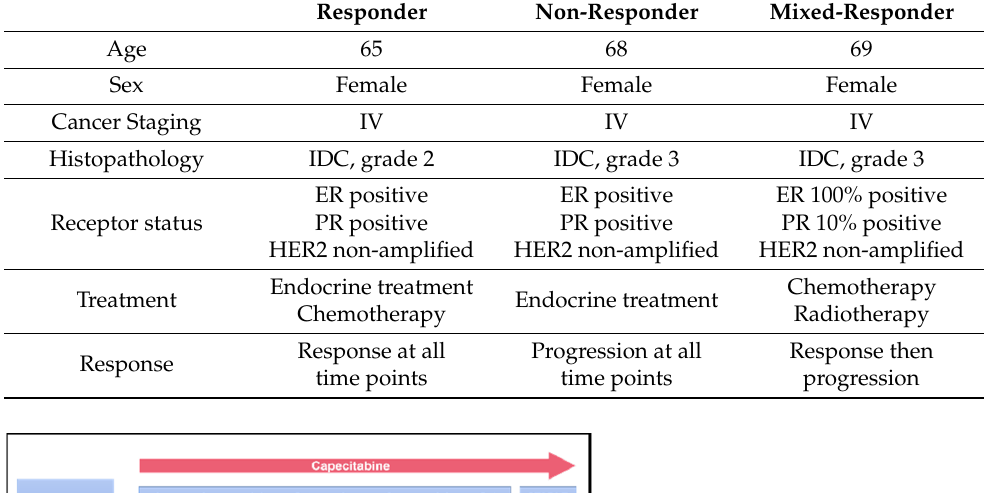
Table 1. Clinical information of three breast cancer patients used to identify markers of disease using extracellular vesicles isolated from blood samples.